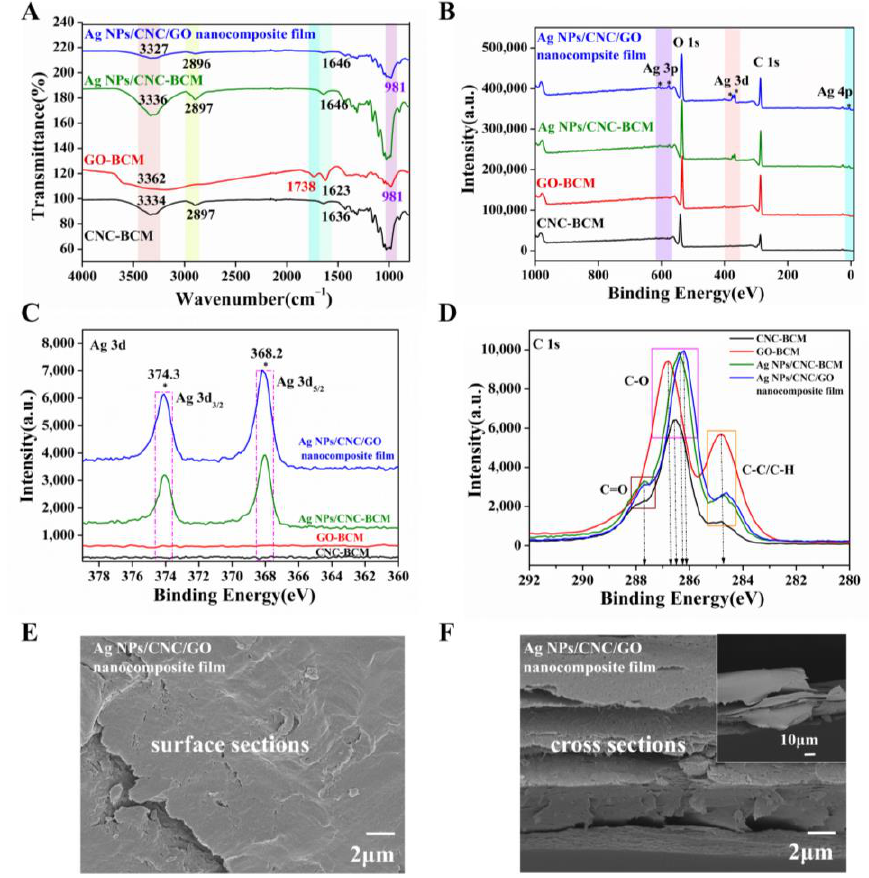
Figure 3. We spin-coated CNC, GO, Ag NPs/CNC and Ag NPs/CNC/GO suspensions onto BCM (serially named as CNC-BCM, GO-BCM, Ag NPs/CNC-BCM, Ag NPs/CNC/GO nanocomposite film). ( A – D ) were the spectra of CNC-BCM, GO-BCM, Ag NPs/CNC-BCM and Ag NPs/CNC/GO nanocomposite film, ( A ) ATR-FTIR spectrum; ( B ) XPS full spectrum; ( C ) XPS partial spectrum of Ag 3d; ( D ) XPS partial spectrum of C1s. ( E , F ) the surface and cross-sectional SEM images of the